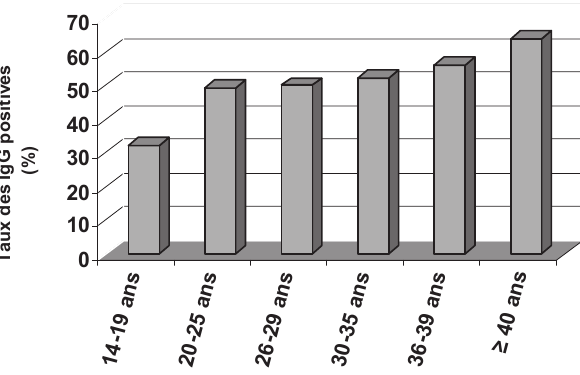
Fig. 1. – Séroprévalence de la toxoplasmose par tranches